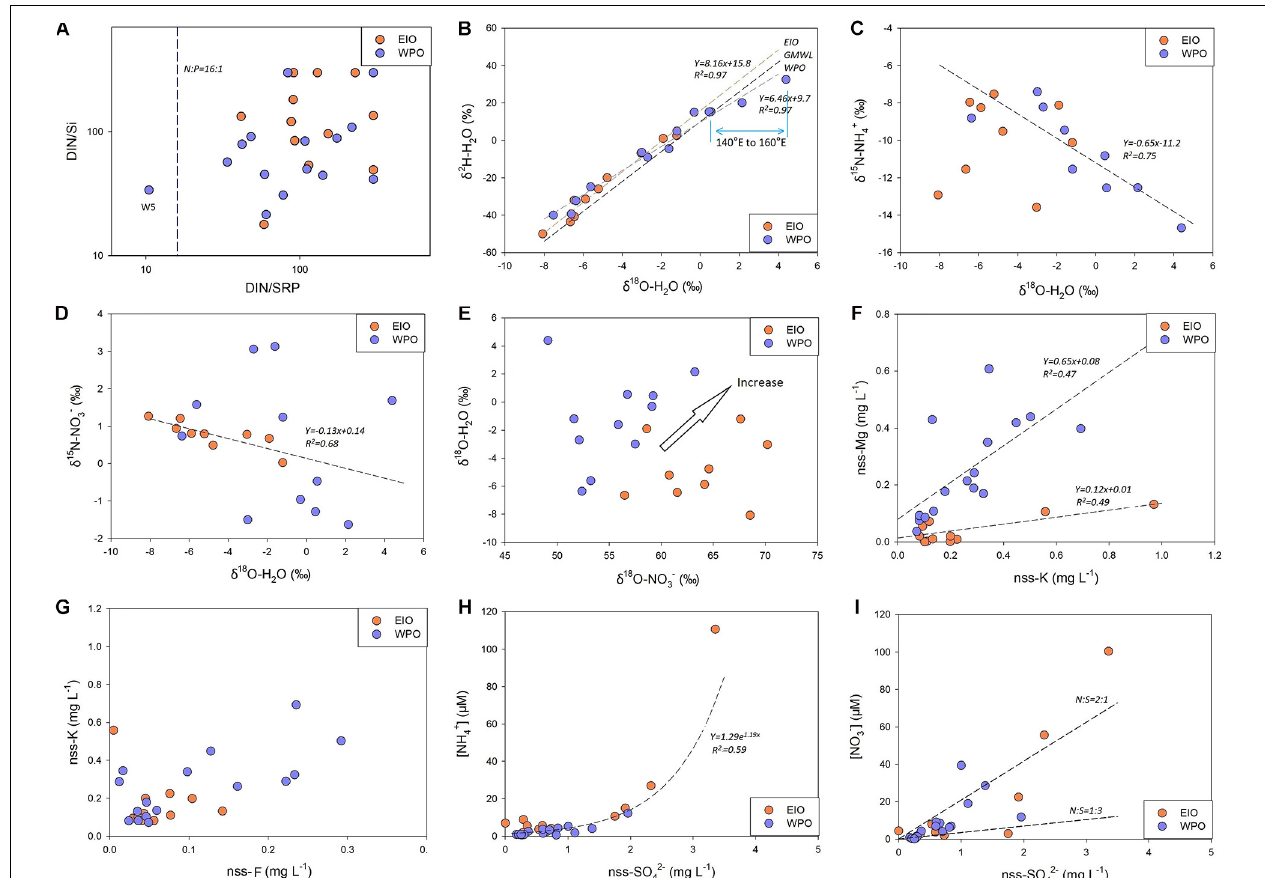
FIGURE 5 | (A) The comparison between DIN:SRP and DIN:Si. Most sites are characterized as P-limitation, and W5 site is characterized as Si-limitation based on the Redfield–Brzezinski ratio. (B) The correlation between δ 2 H–H 2 O and δ 18 O–H 2 O in rainwaters. GMWL is the global meteoric water line with a slope of 8 and an intercept of 10. Different curves are found in the EIO and WPO. (C,D) δ 15 N–NH 4 + / δ 15 N–NO 3 − and δ 18 O–H 2 O from samples obtained in the WPO and EIO, respectively; it shows the regression curve between δ 15 N–NH 4 + and δ 18 O–H 2 O in the WPO (C) , as well as δ 15 N–NO 3 − and δ 18 O–H 2 O in the EIO (D) . (E) δ 18 O–NO 3 − vs. δ 18 O–H 2 O in both EIO and WPO, highlighting the increasing trend. (F,G) Correlations between nss-K + and nss-Mg 2 + /nss-F − concentrations. (H,I) Correlations between NH 4 + /NO 3 − concentration with nss-SO 42 −